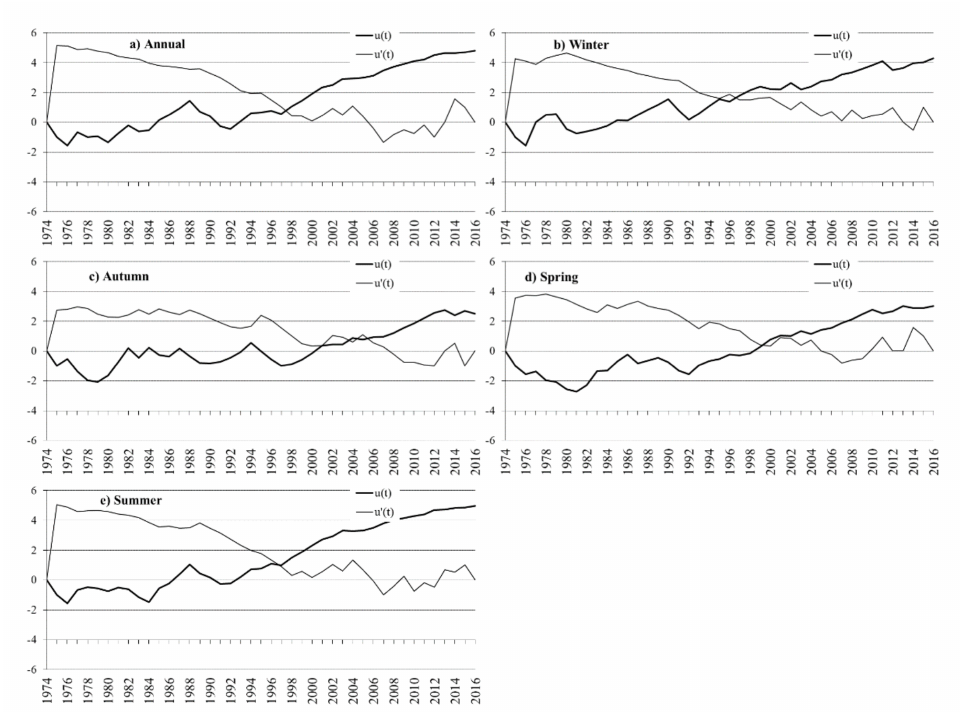
Figure 5. Graphical representation of the series u ( t ) and the retrograde series u ’( t ) of the sequential version of the Mann–Kendall test for ( a ) annual, ( b ) winter, ( c ) autumn, ( d ) spring, and ( e ) summer PET in the University Forest of